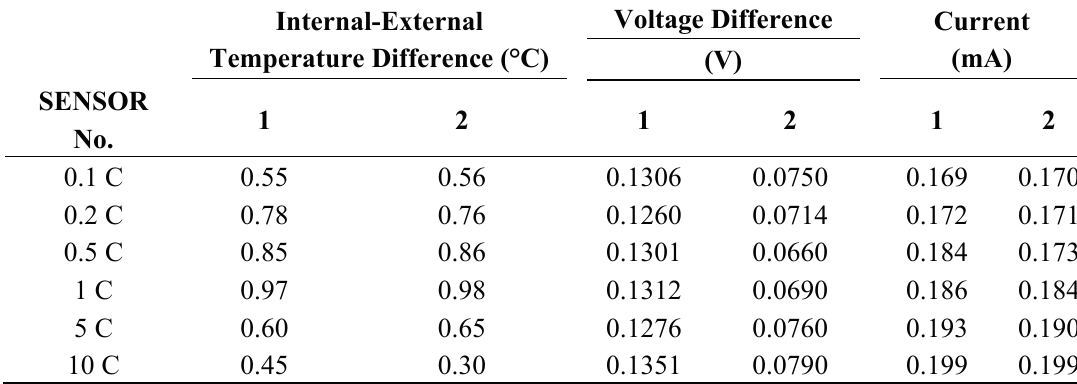
Table 8. Internal monitoring data of the persistence effect test for lithium battery